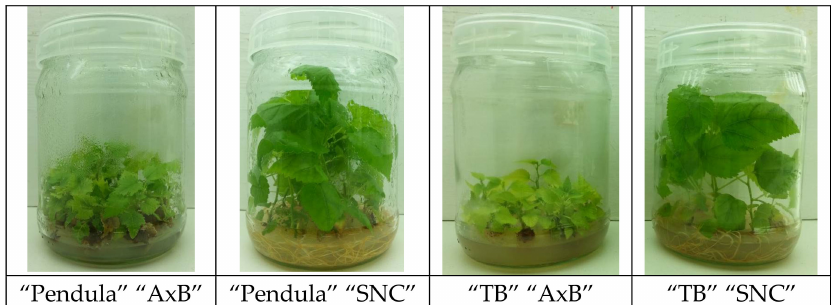
Figure 8. Performance of in vitro shoot cultures of white mulberry clones grown on cytokinin-containing (“AxB”) and cytokinin-free (“SNC”) medium. “TB”—”Tarnobrzeska”—local